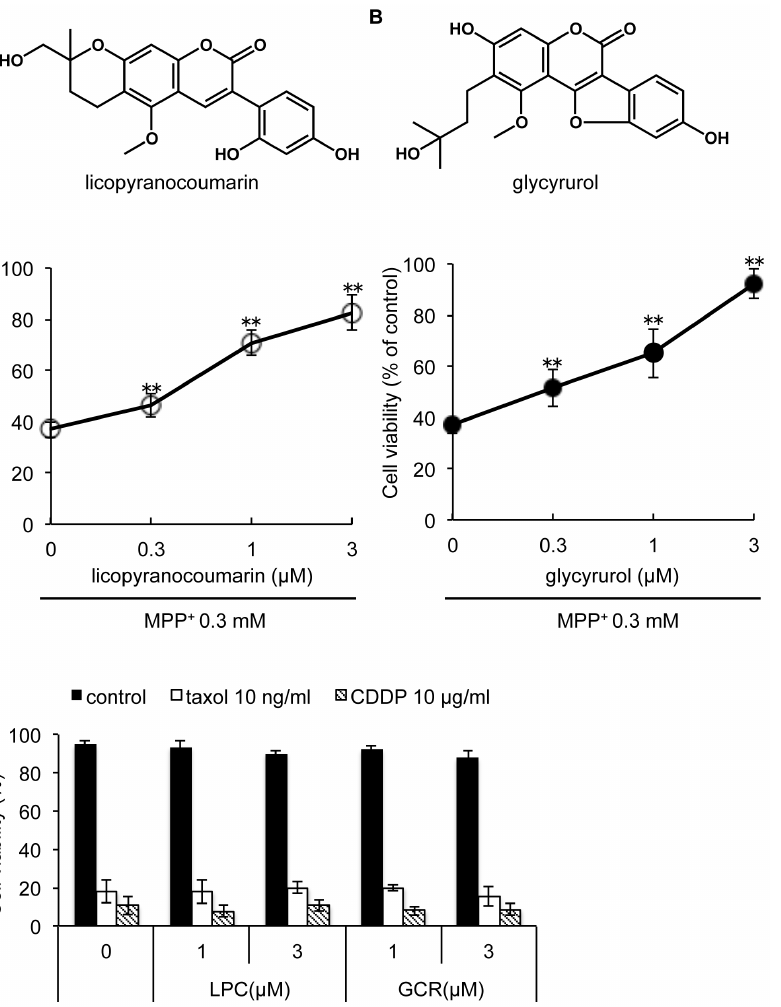
Figure 3. Licopyranocoumarin and glycyrurol prevented MPP + -induced cell death. Structures of ( A ) licopyranocoumarin (LPC) and ( B ) glycyrurol (GCR). ( C ) NGF-differentiated PC12D cells were treated with various concentrations of LPC or GCR in the presence of 0.3 mM MPP + for 48 h. Cell viability was evaluated by trypan blue dye exclusion assay. ( D ) PC12D cells were treated with various concentration of LPC or GCR in the presence of 10 ng/ml taxol or 10 m g/ml cisplatin (CDDP) for 48 h. Values are the means of three independent experiments; bars, s.d. ** p , 0.01 compared with MPP + group cells.